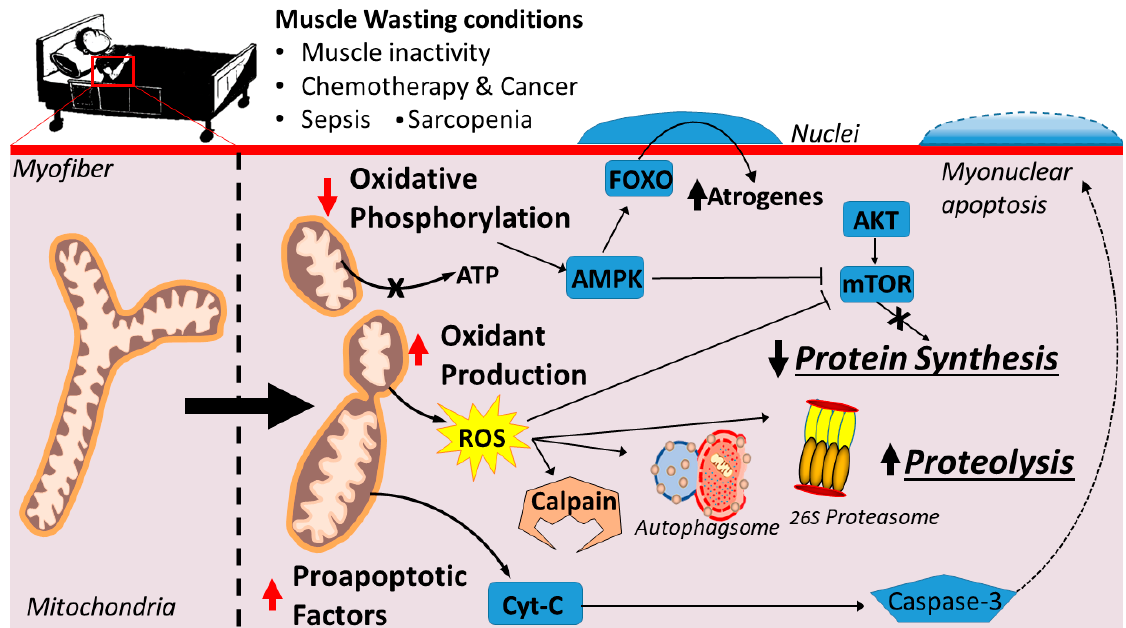
Figure 2. Mitochondrial dysfunction arising from conditions of prolonged muscle inactivity, aging, chemotherapy, cancer, and sepsis, resulting in muscle wasting. Decreased respiratory capacity decreases ATP content and activates AMPK signaling. Increased ROS emissions activate the major proteolytic pathways and inactivates muscle protein synthesis pathways. The release of mitochondrial-derived proapoptotic factors activates caspase-3 and mediates myonuclear